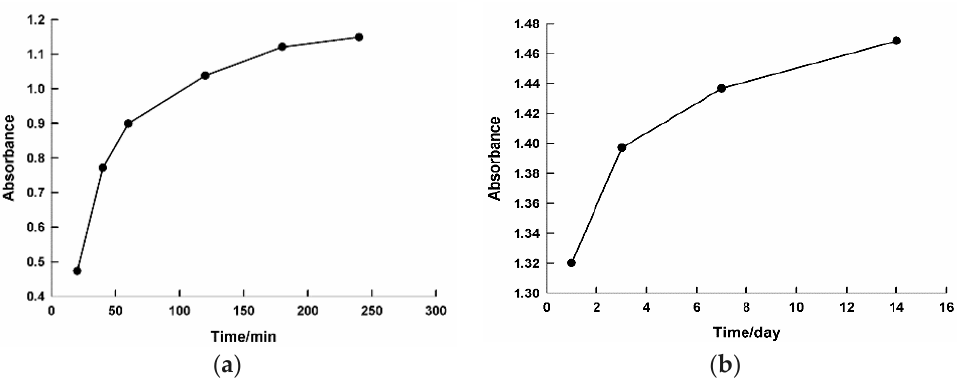
Figure 2. Plot of the intensity of surface plasmon resonance at 535 nm against the reaction time. The time period on the x axis is the difference, graph ( a ) time is by minutes however graph ( b ) is by days.